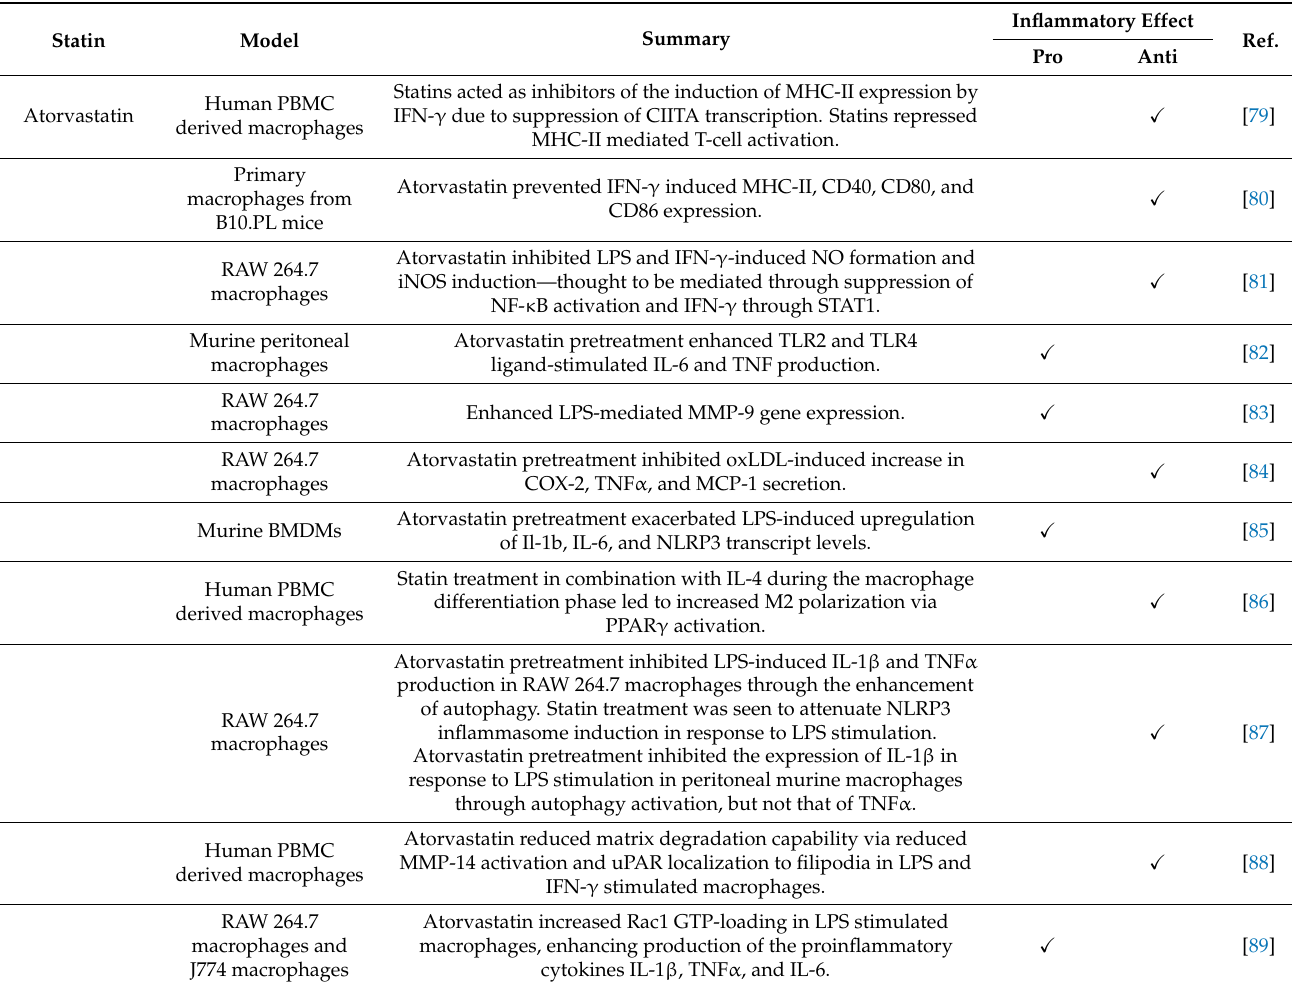
Table 2. The effects of statins on macrophages in vitro. Abbreviations: PBMC, peripheral